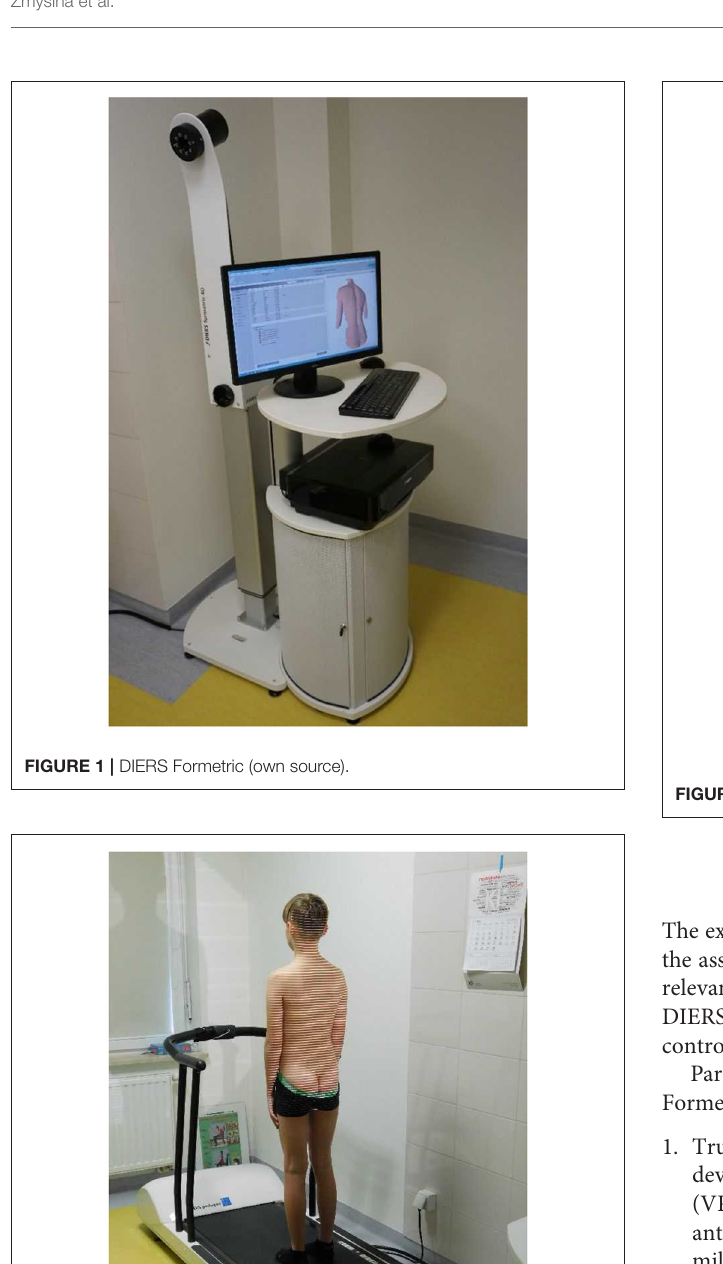
patient’s back. The test room was darkened for optimal data recording. The camera was set at the height of the angles of the patient’s lower shoulder blades. After the precise setting of the equipment and positioning of the examined person, an electronic record of the body posture and computer analysis followed.